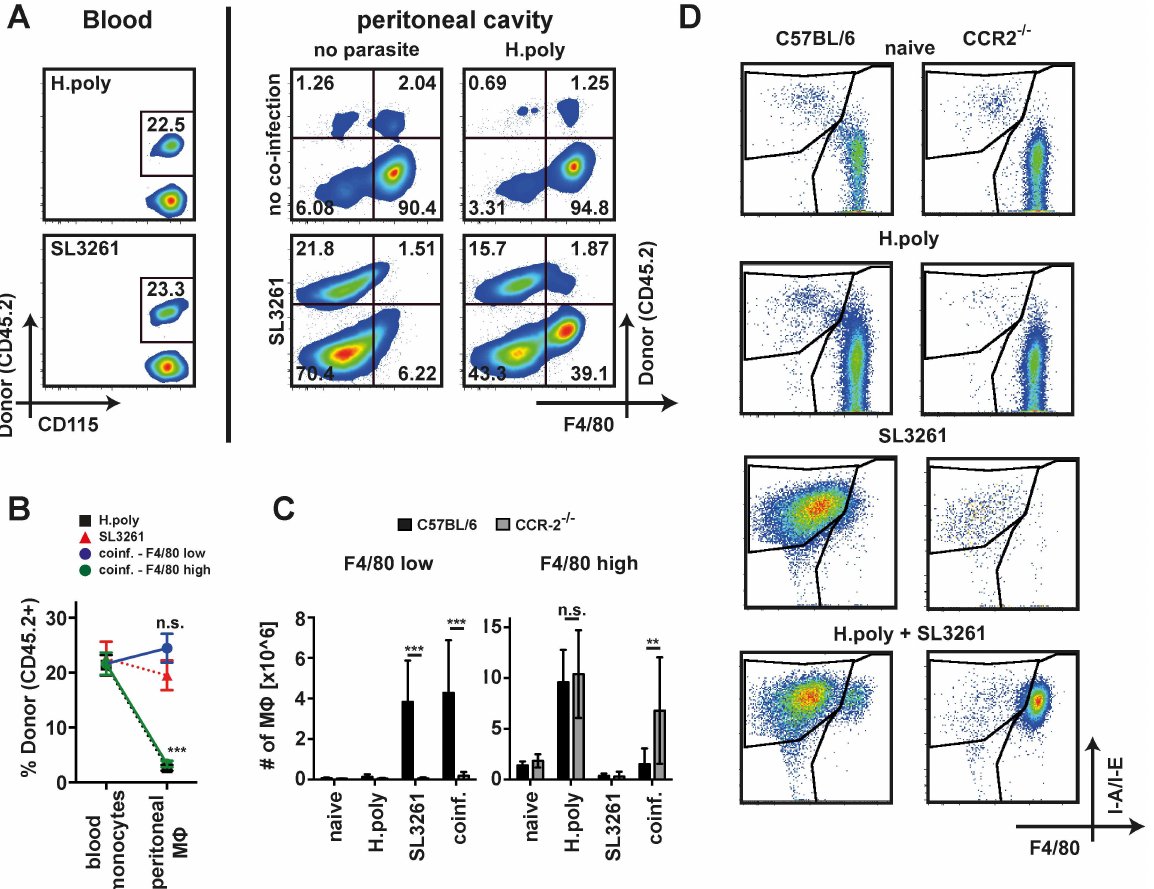
Fig 4. Bacterial co-infection leads to recruitment of M Φ from the vasculature. (A) Representative flow diagrams depicting CD45.2chimerism in Ly6C high blood monocytes(CD11b+CD115+Ly6C high ) or peritonealM Φ (lineage-CD11c-F4/80+MHC+) in Cd45.1 host mice after partially shielded γ -irradiation, and subsequent single (top right, bottom left) or co-infection (bottom right). (B) Quantitative analysisof chimerismin Ly6C high blood monocytes and F4/80 high (green circles) or F4/80 low (blue circles) M Φ in co- infected mice analysedin E. As comparisonchimerismof total M Φ in single H . polygyrus (filled squares) or SL3261(red triangles) infected animalsis shown. Data pooledfrom two separate experiments with 5 animalsper group each. Asterisks indicate statistical differences betweenblood monocytes and peritoneal M Φ in co-infectedanimals. (C) Number of F4/80 high and F4/80 low peritonealM Φ in SL3261 (SL3261), H . polygyrus (H.poly) co-infected(coinf.) or naive C57BL/6(black bars) or Ccr2 -/- mice (grey bars). Data pooled from two independentexperiments with 4–6 mice per group. (D) Representative dot plots depictingM Φ isolated in C. ** : p < 0.01, *** ; p < 0.001;n.s.: not significant.